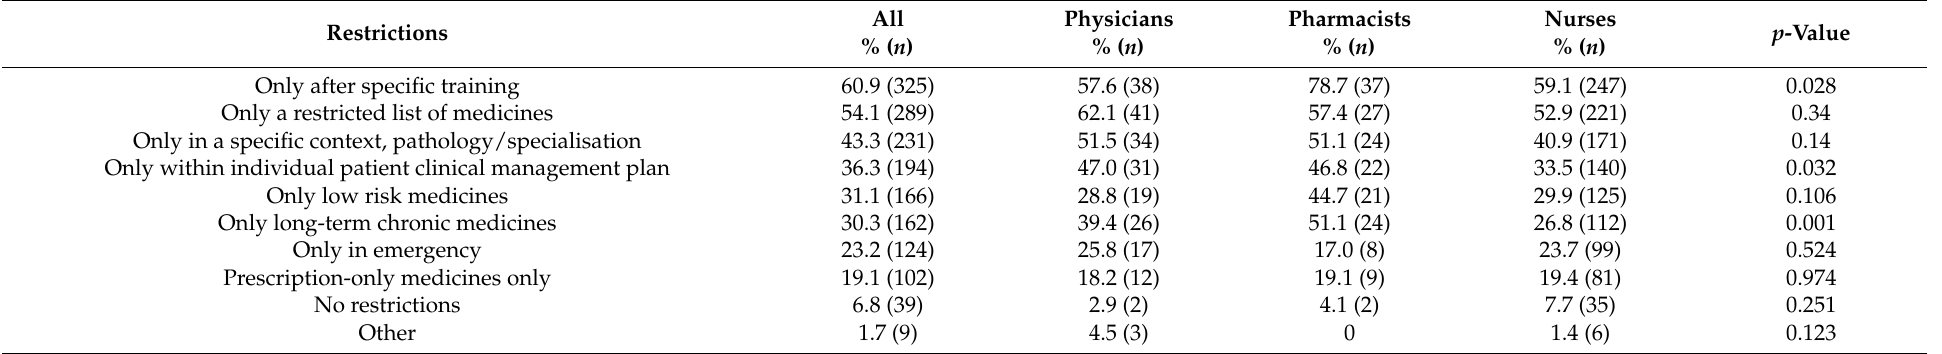
Table A2. Restrictions to optimise nurse prescribing in an ideal interprofessional healthcare situation, according to physicians, pharmacists and nurses ( n =